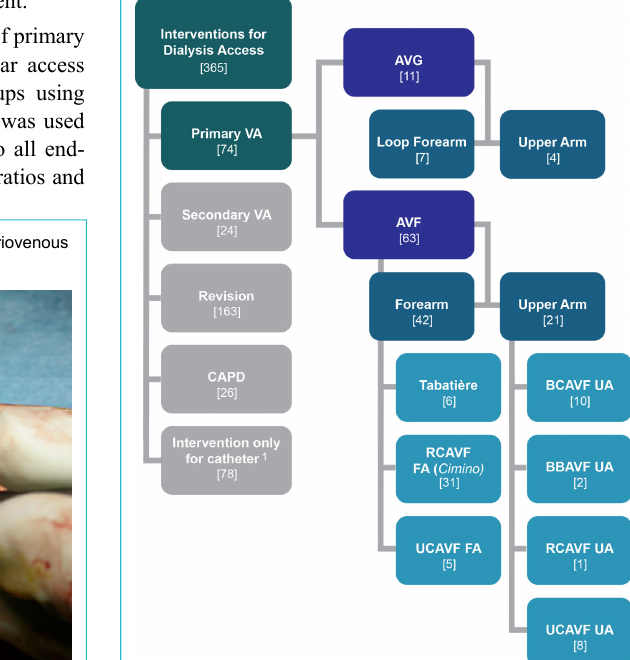
Figure 2: Overview of interventions for renal replacement therapy January 2013 to December 2014.AVF = arteriovenous fistula; AVG = arteriovenous graft; BBAVF = brachiobasilic AVF, upper arm; BCAVF = brachiocephalic AVF, upper arm; RCAVF =radiocephalic AVF (Cimino), forearm; UCAVF = ulnocephalic AVF forearm and upper arm; VA = vascular access 1 45 changes (2 non-tunnelled), 18 removals, (3 non-tunnelled), 15 new inserted (2